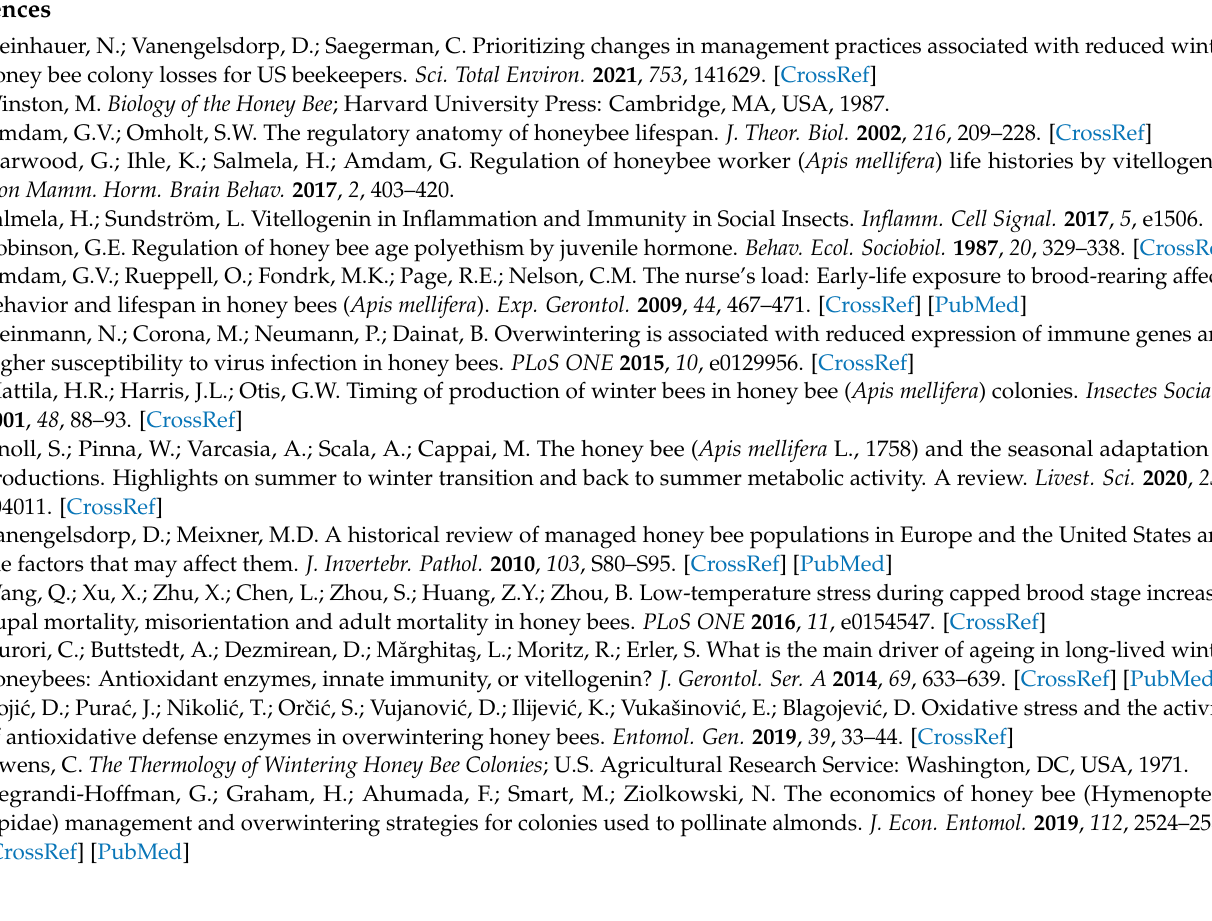
Table S3: Ileum comparisons, Table S4: Rectum comparisons, Table S5: Bacterial–fungal abundance, Table S6: Repeated measures